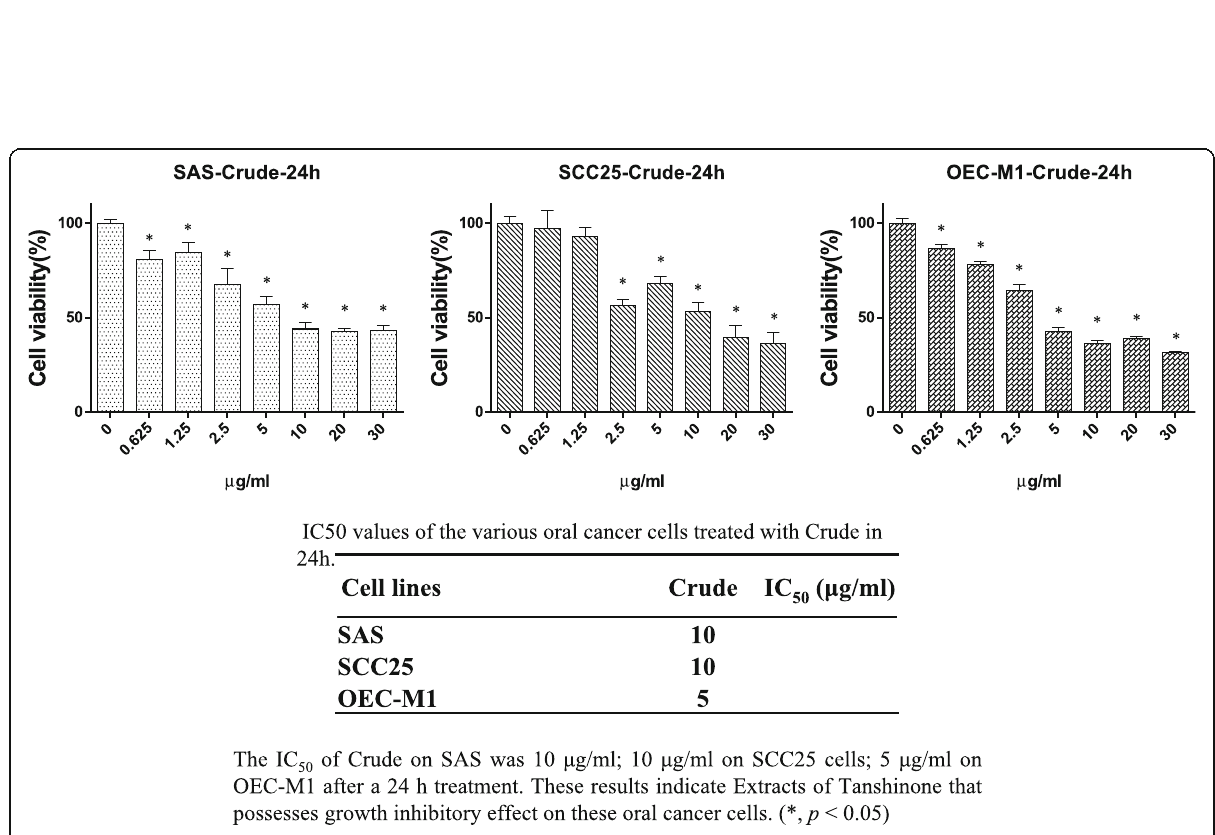
Fig. 2 Inhibition of oral cancer cell (SAS, SCC25, and OEC-M1) growth in vitro via the Danshen crude. The antioral cancer efficacy of the Danshen crude on three oral cancer cell lines (SAS, SCC25, and OEC-M1) treated for 24 h. The extract significantly reduced the cell viability of all three OSCC lines in a dose-dependent